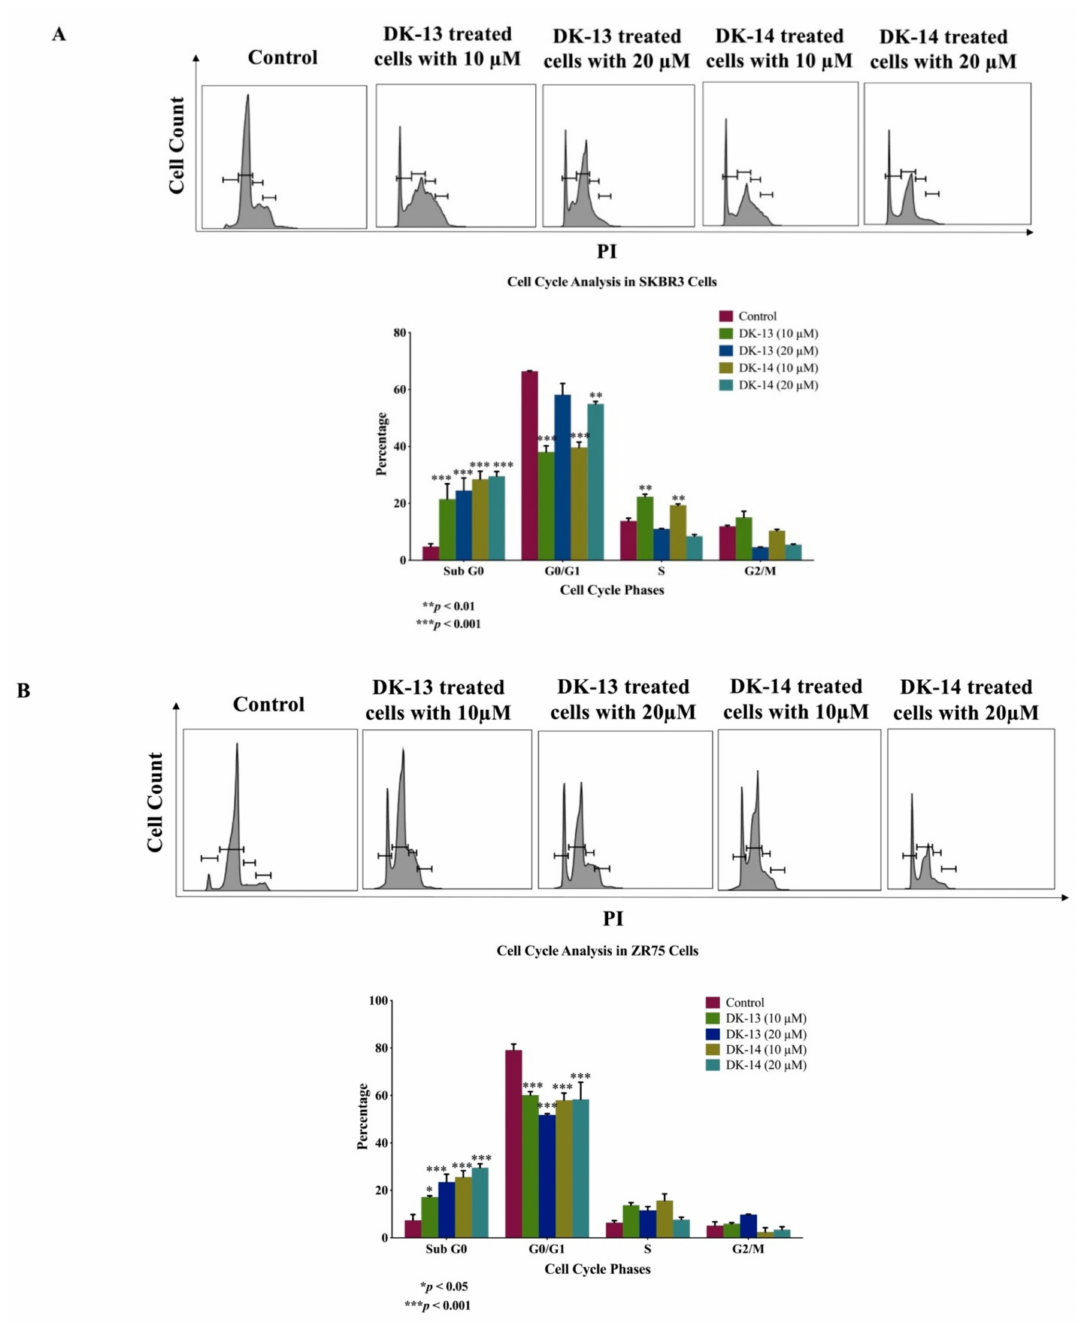
Figure 1. ( A,B ). Cell cycle flow cytometry analysis of HER2-positive breast cancer cell lines, ( A ) SKBR3 and ( B ) ZR75. Cells were incubated with 10 and 20 µ M of chalcone compounds, DK-13 or DK-14, for 48 h followed by staining of cells with propidium iodide (PI). Representative DNA content histogram showing the phases of sub G0, G0 \ G1, S, and G2/M on tested cell lines upon treatment with chalcone compounds, DK-13 and -14 compared to controls. The cell cycle histogram results reveal that chalcone compounds, DK-13 and -14 at lower concentrations (10 µ M) can disrupt cell mitosis by arresting cells in the S phase and at higher concentrations (20 µ M) induce apoptosis. Quantification is represented as the mean ± SEM ( n =